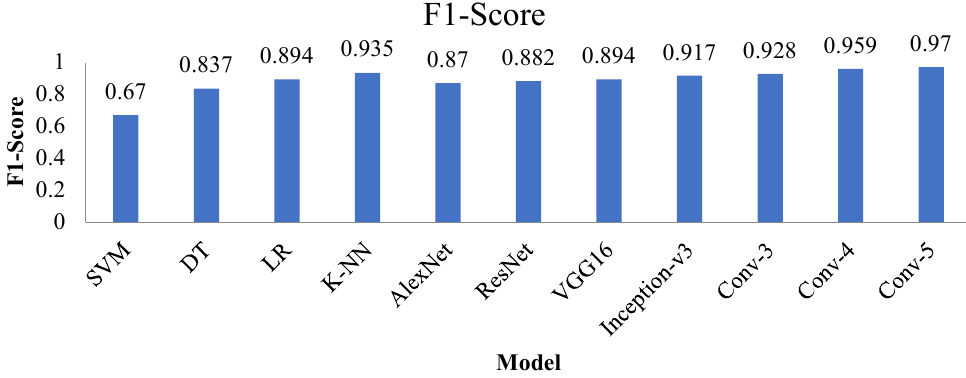
Figure 20. F1-Score value of all the advanced and proposed techniques.